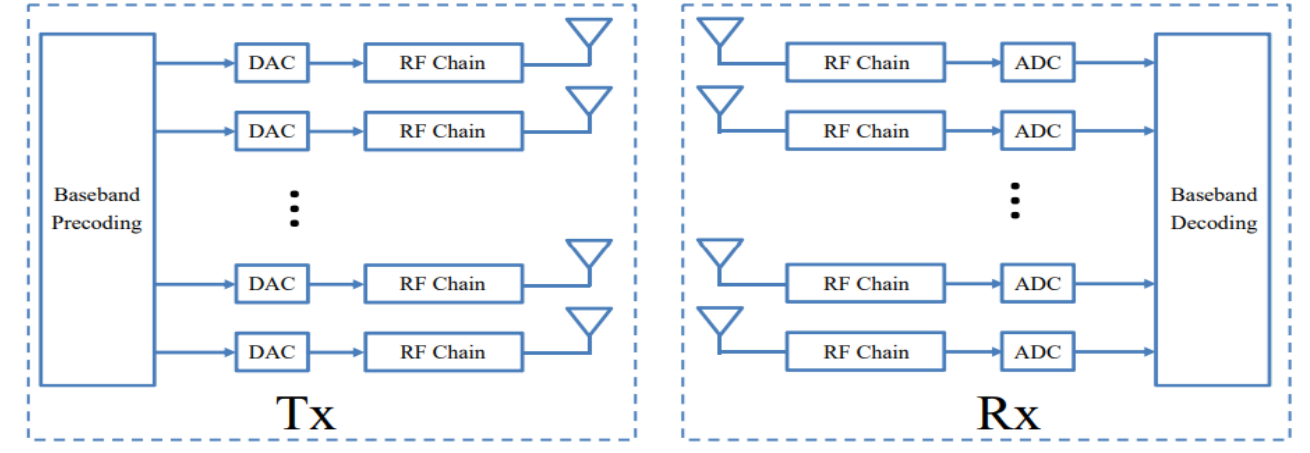
Figure 3. Digital beamforming [31].